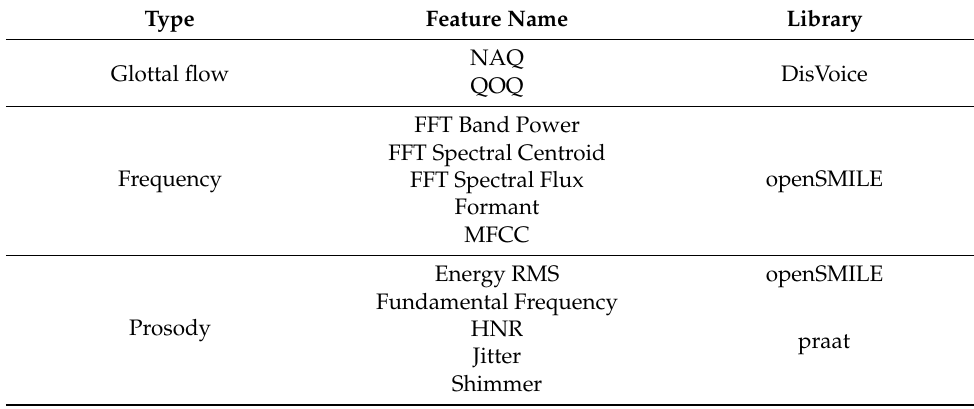
Table 3. Acoustic features for the prediction and libraries for the